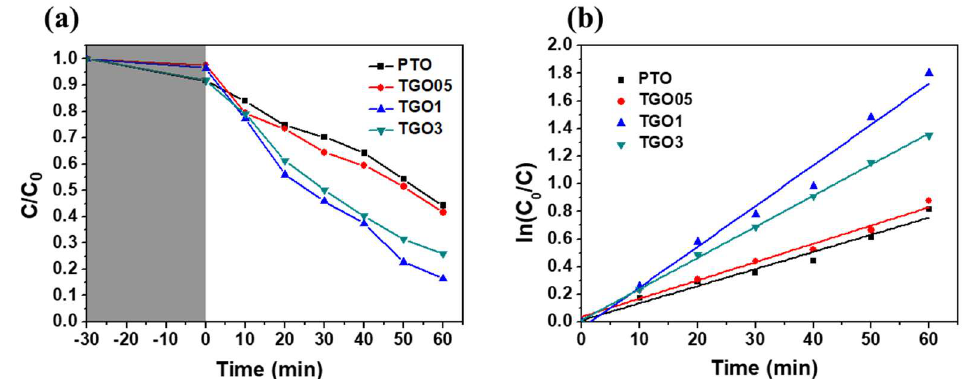
Figure 6. Photocatalytic activities of pristine SnO 2 aerogel (PTO) and SnO 2 aerogel/reduced graphene oxide (rGO) nanocomposites with different rGO loadings (0.05 wt.%: TGO05; 0.1 wt.%: TGO1; 0.3 wt.%: TGO3), represented as ( a ) the degradation of methyl orange (MO) dye (in terms of concentration ratio C/C 0 , where C 0 and C are the MO concentrations at initial time t 0 and a given ultraviolet irradiation time t) and ( b ) its reaction rate during ultraviolet irradiation time.